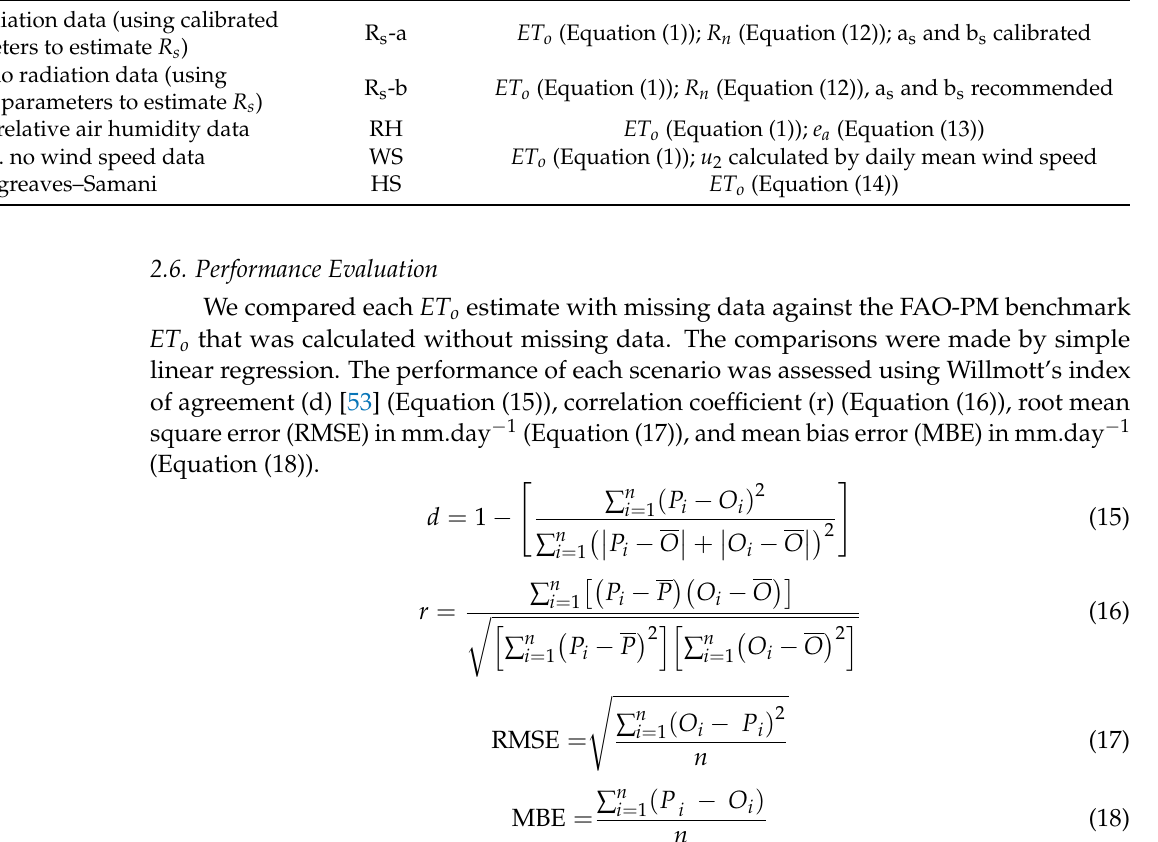
Table 1. Summary of ET o calculations with missing climatic data. Method Symbol Calculation of ET o FAO-PM, no radiation data (using calibrated parameters to estimate R s